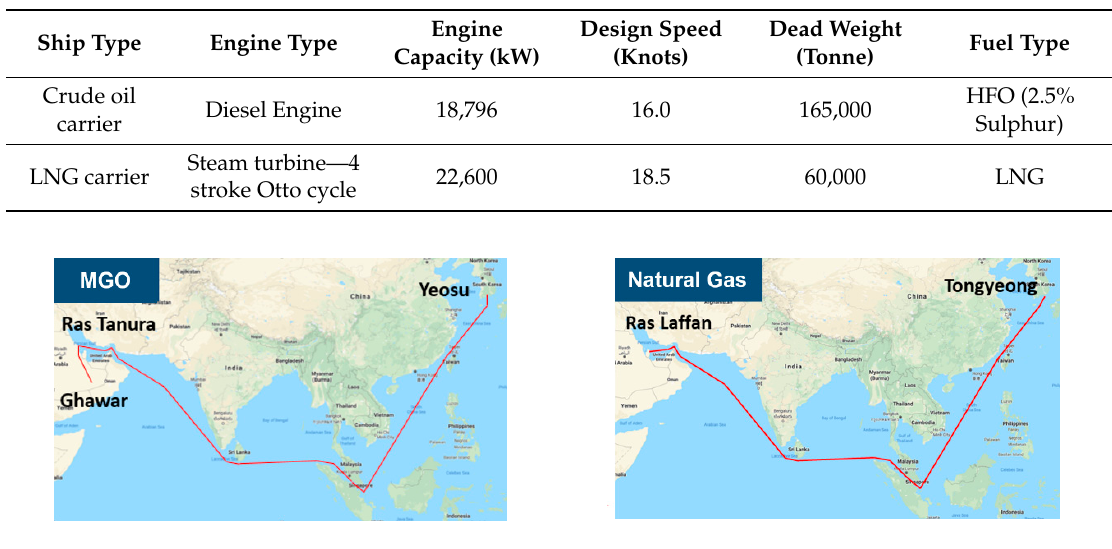
Figure 4. Ocean transportation routes of MGO and natural gas.